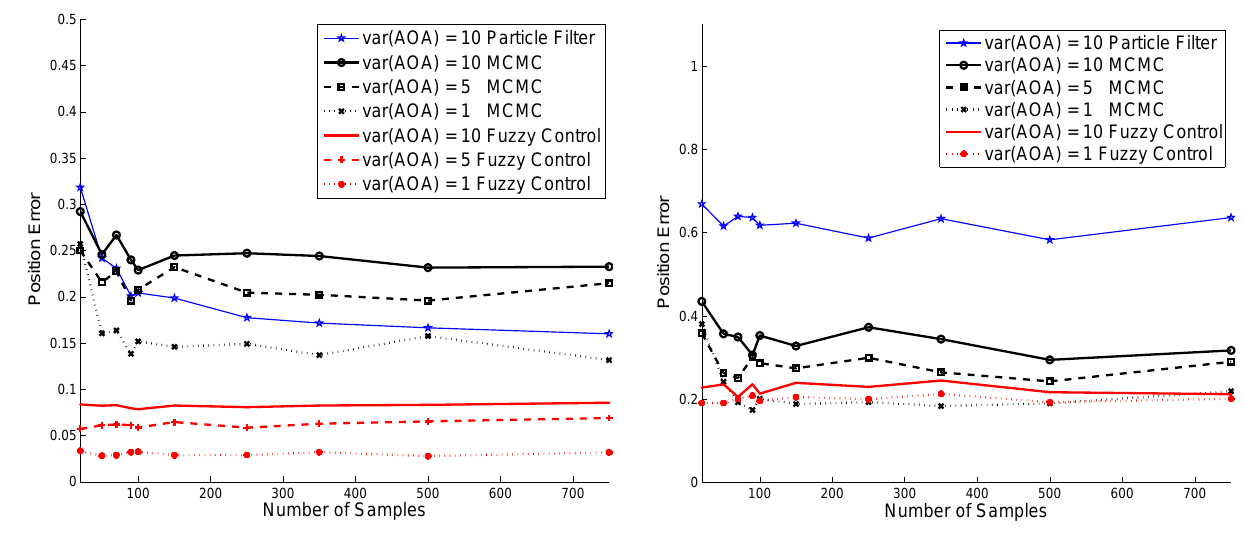
Figure 16. The estimation performance with varying the variance of angle information; σ 2 = 0.01 (left) and σ 2 = 0.5 d